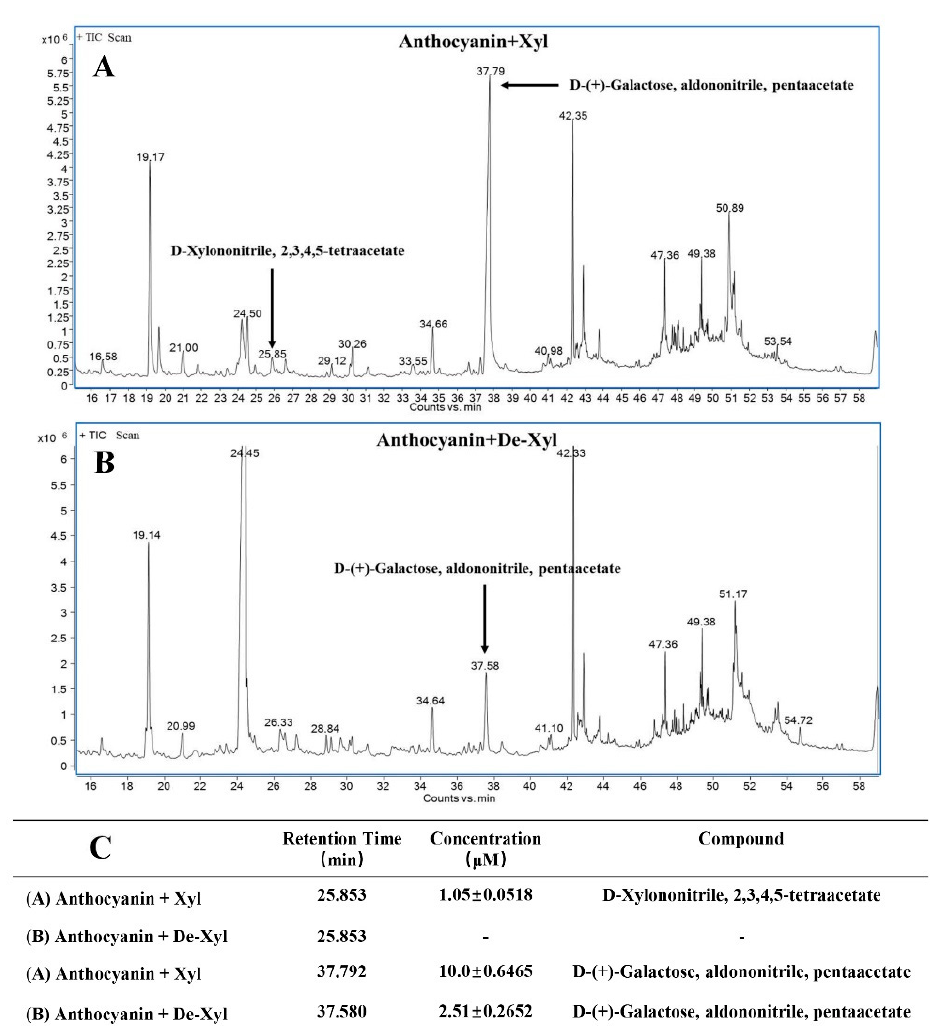
Figure 5. GC-MS detection of the monosaccharides released from the B. calycina anthocyanins by the action of BcXyl. ( A,B ) GC-MS (gas chromatography-mass spectrometry) chromatograms for monosaccharide detection after anthocyanin degradation by BcXyl. The degradation reactions were set up as described in (Figure 4B–D). The release of monosaccharides from 6.4 μ M anthocyanins incubated with native (A) and denatured (B) BcXyl for 2 h were subjected to GC/MS analysis. ( C ) The contents of the detected monosaccharides in (A,B). Concentrations of monosaccharides were based on the comparison of the relevant peak area in the GC-MS chromatograms to the standard curves. The values are means ± standard deviations ( n = 3).